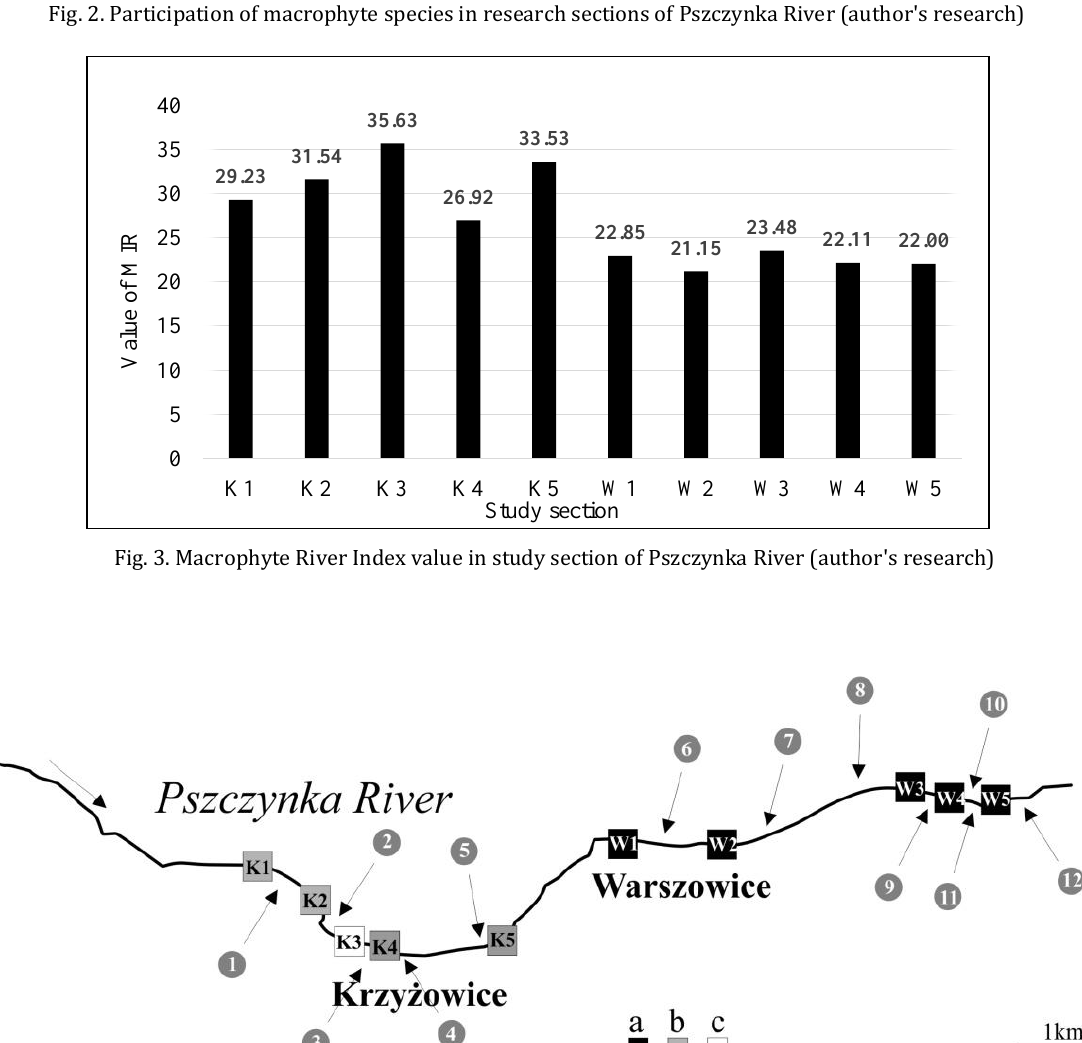
Fig. 2. Participation of macrophyte species in research sections of Pszczynka River (author's research)